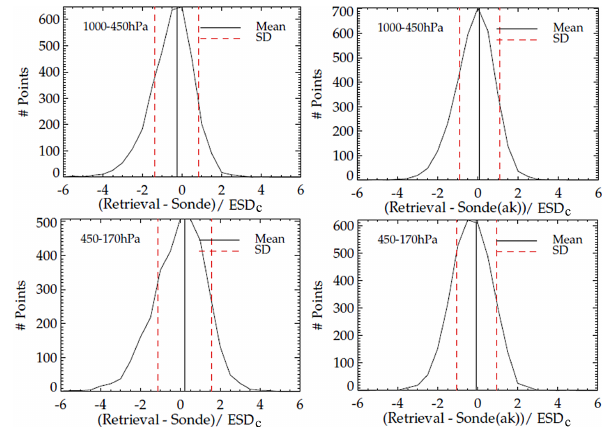
Figure 6. Histograms of differences between retrieved and sonde layer amounts relative to the estimated standard deviation (ESD) on each layer, for the lower-most and second subcolumns (top and bot- tom), with and without averaging kernels applied (right and left). The mean/standard deviation values are as follows: − 0.184/1.12 (top left), 0.2/1.09 (top right), 0.158/1.41 (bottom left), 0.135/1.12 (bottom